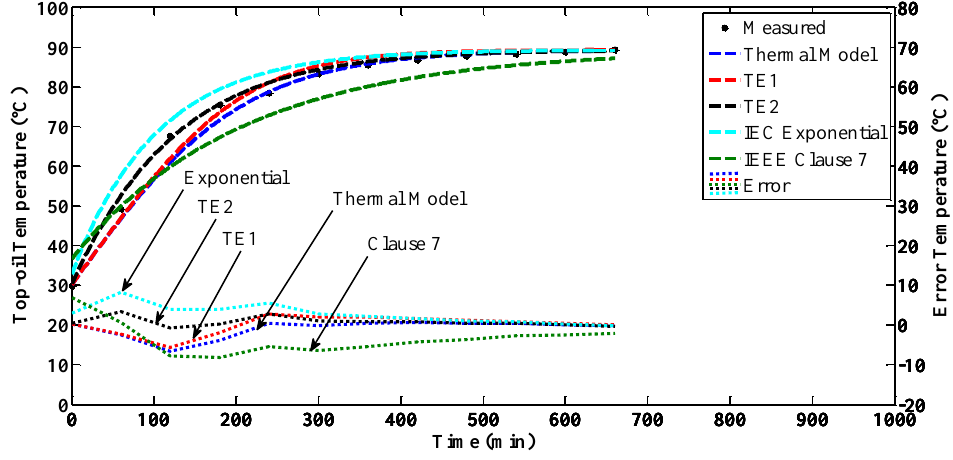
Figure 10. TOT based on different thermal models for TX4.